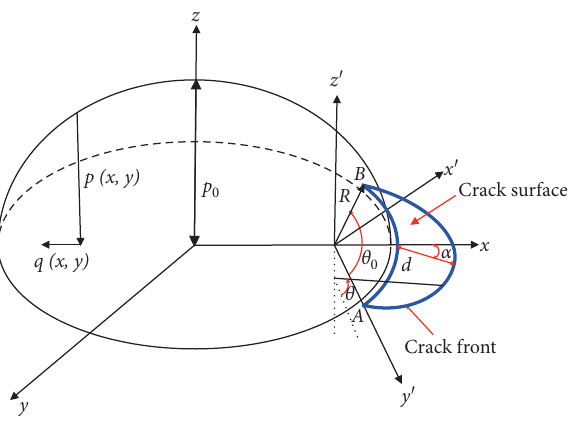
Figure 4: Crack and Hertzian contact stress model.